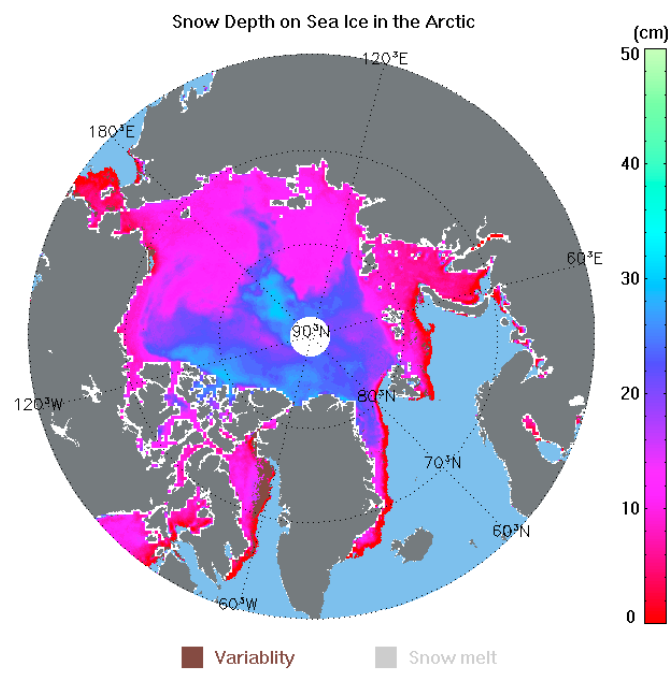
Figure 14. Snow depths on Arctic sea ice on 3 January 2011. This figure denotes the averaged snow depth for three days from 1–3 January 2011. To eliminate the influence of land on the retrieval, we removed the data close to land using a 3 × 3 grid